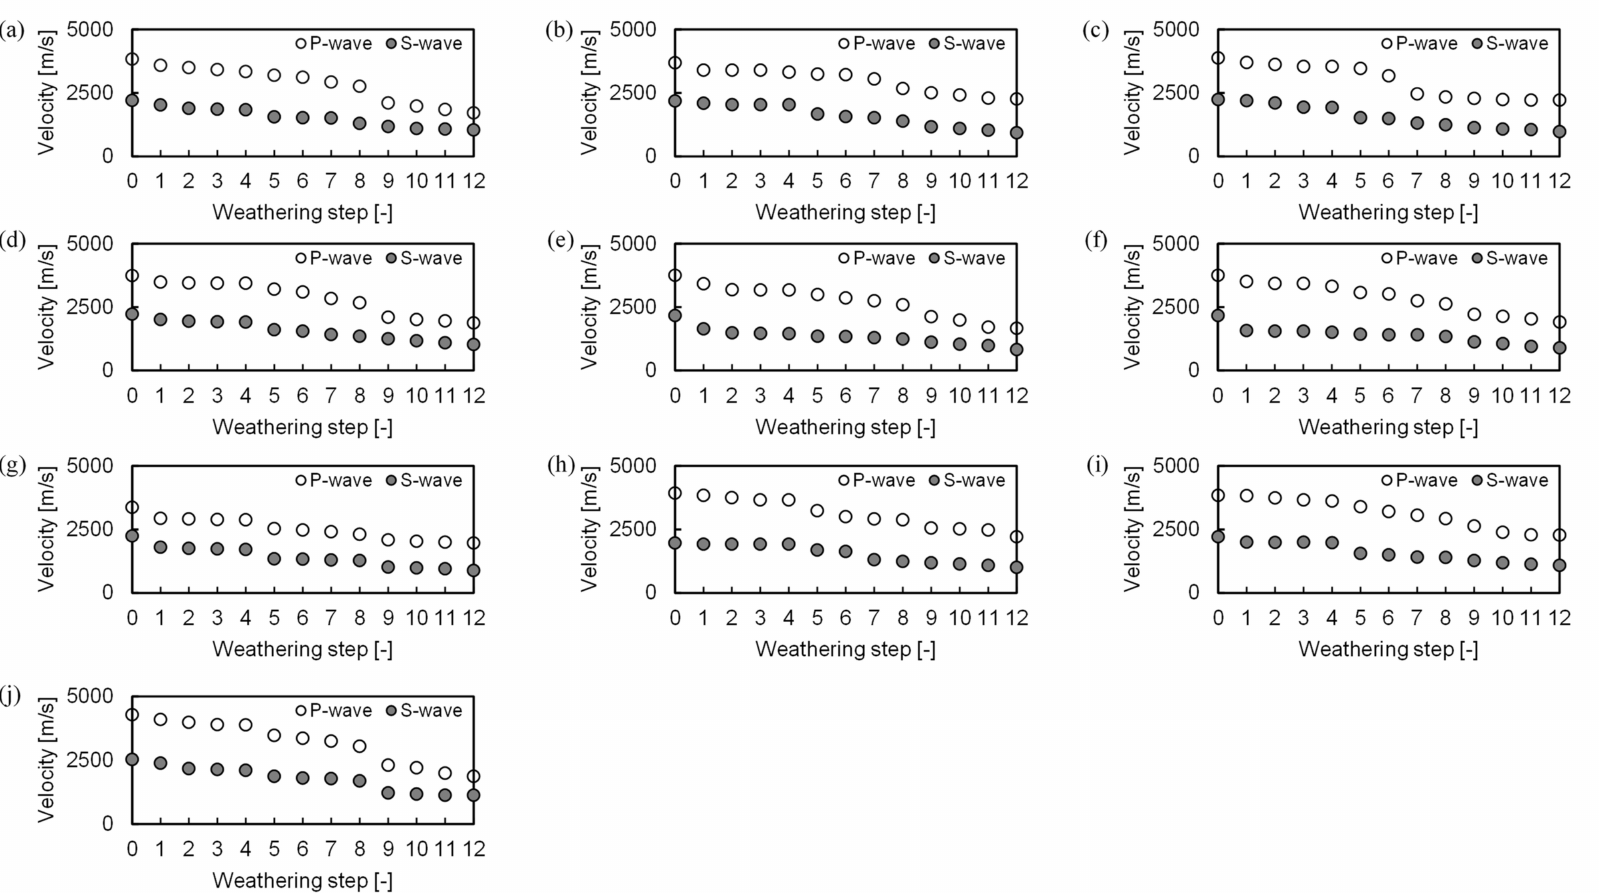
Figure 6. Measured elastic wave velocities for each sample: ( a ) albite 1, ( b ) albite 2, ( c ) albite 3, ( d ) albite 4, ( e ) quartz 1, ( f ) quartz 2, ( g ) quartz 3, ( h ) biotite, ( i ) calcite, and ( j )